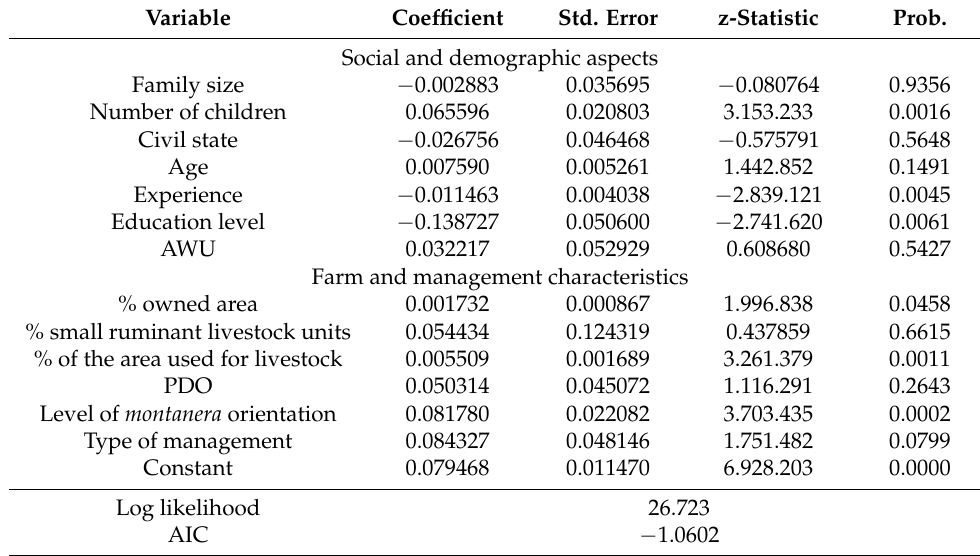
Table 6. Statistical analysis of Tobit